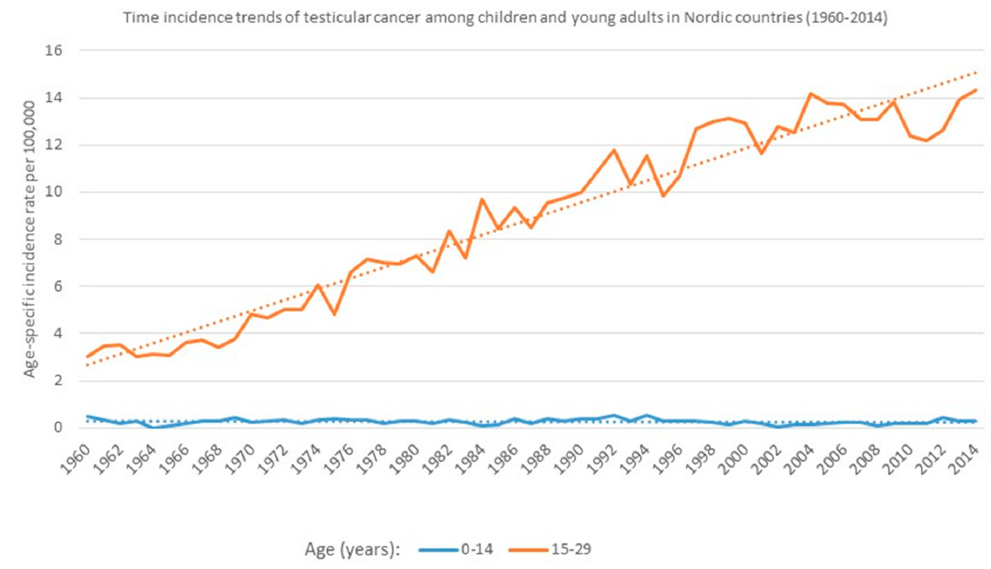
Figure 2. Age-specific time incidence rates of testicular cancer (TC) among children and young adults (age-adjusted according to the world population) in the period 1960–2014, of all Nordic countries (Sweden, Denmark, Finland, Norway and Iceland). Analyses based on data obtained from NORDCAN, 2016.